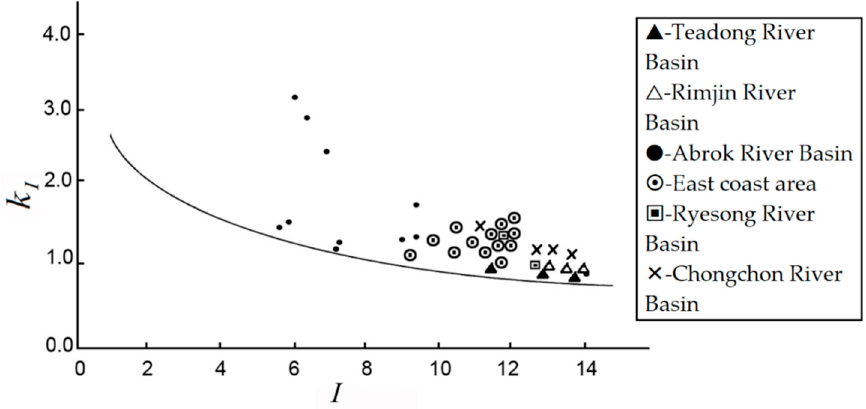
Figure 11. Scatter plot of k (cid:48)